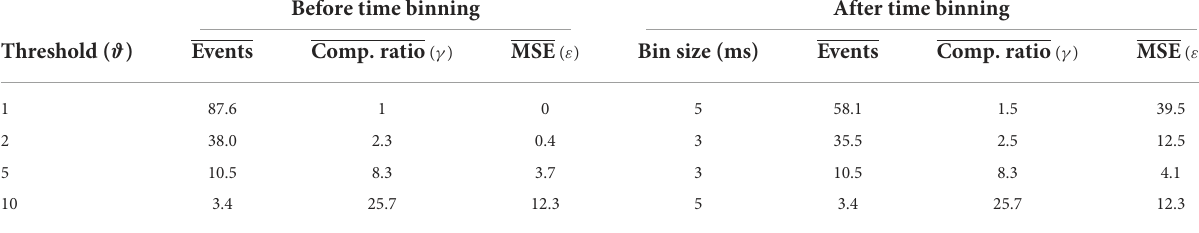
TABLE 2 Characterization of event-based encoding for each of the generated datasets at different threshold values. Before time binning After time binning